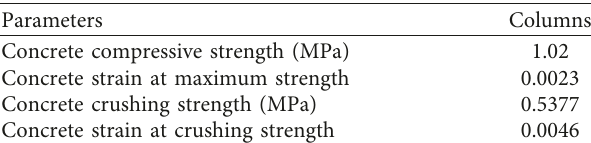
Table 3: Parameters of masonry material